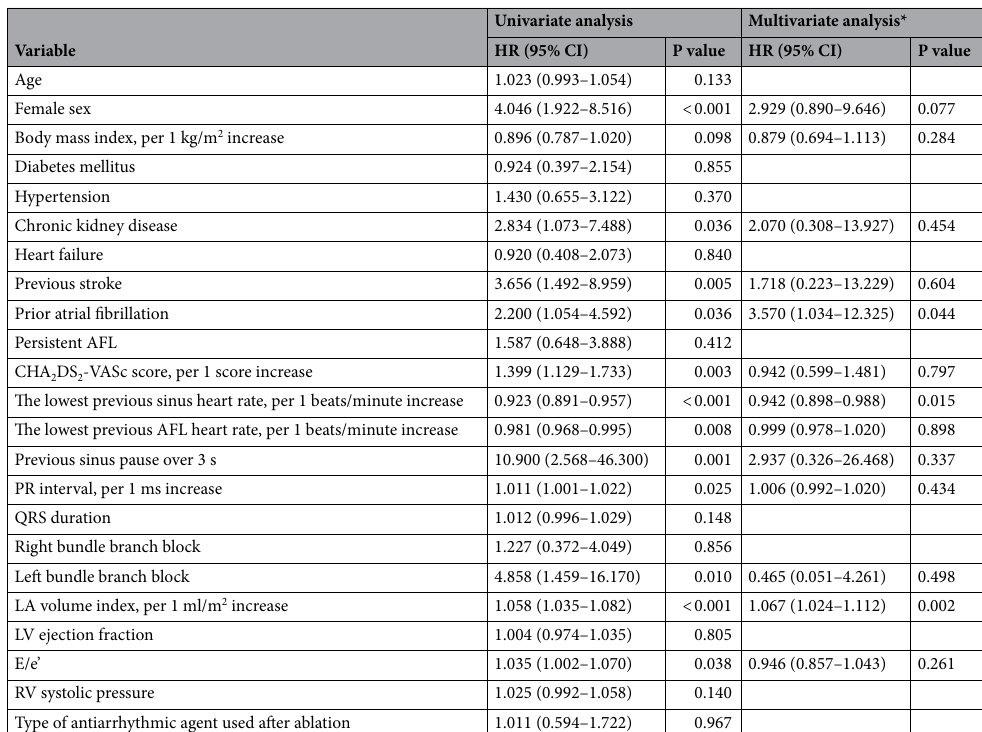
Table 3. Independent predictors for PPM implantation after CTI-dependent AFL ablation. *The discriminant ability of multivariable model was 0.866 (95% CI 0.774–0.957). AFL atrial flutter, CI confidence interval, CTI cavotricuspid isthmus, HR hazard ratio, LA left atrium, LV left ventricle, PPM permanent pacemaker, RV right ventricle.